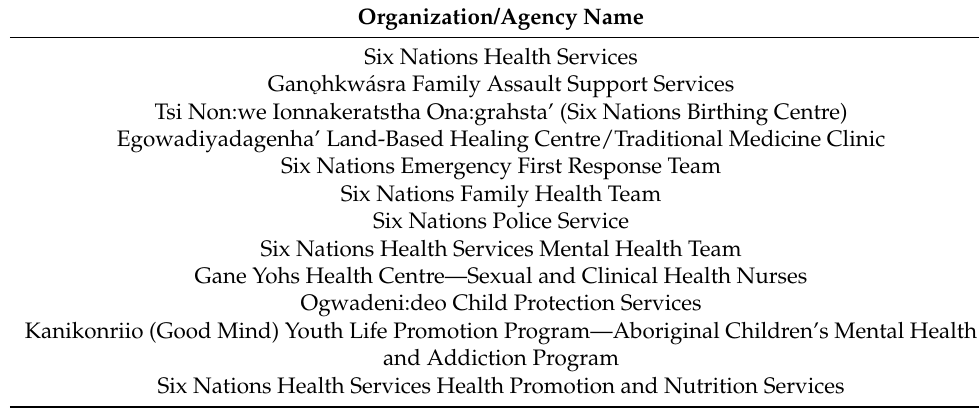
Table 1. Health care and Social Service Agencies Involved in